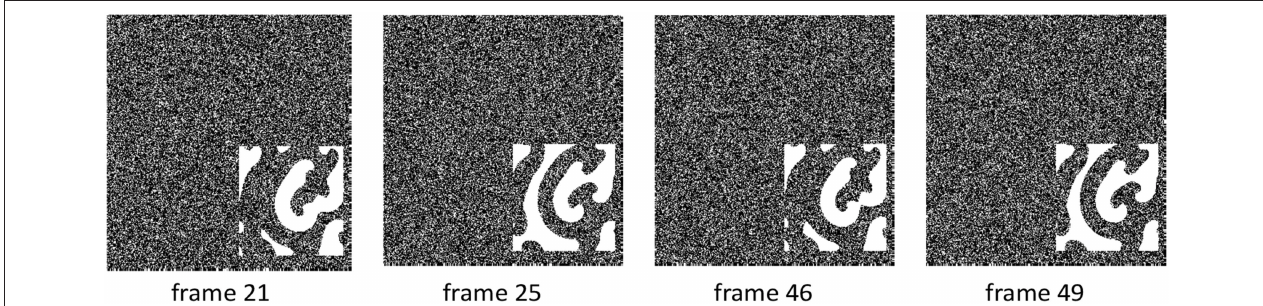
FIGURE 10 | Simulation characterized by a sequence of random images with a spiraling wave of limited time duration added to it. The spiraling pattern was obtained by means of a complex Ginzburg-Landau equation, with parameters b